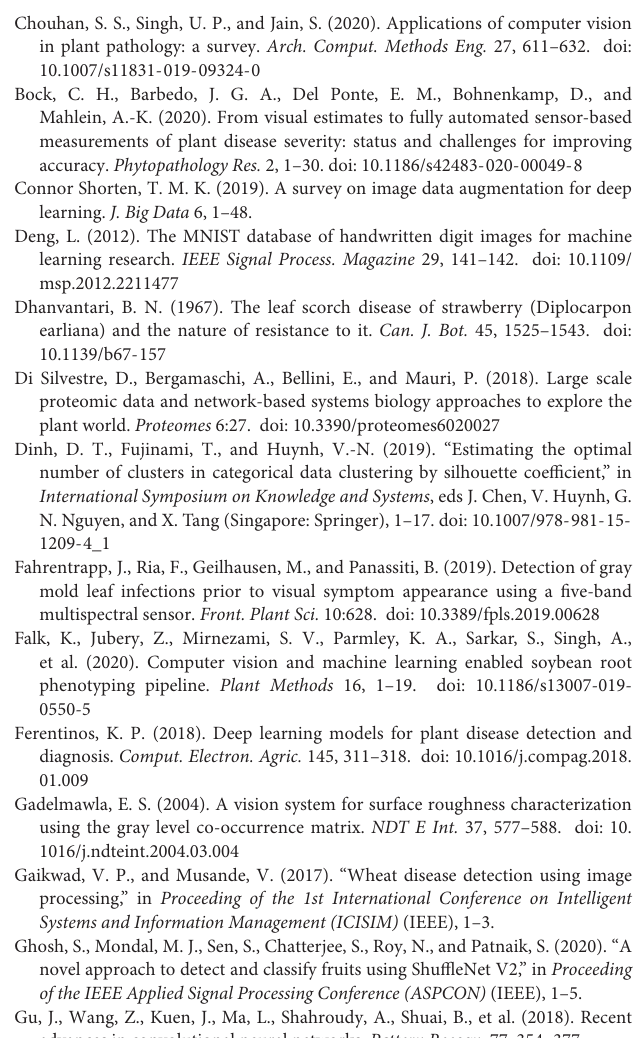
Supplementary File 1 | The sample assignment for each dataset involved in this